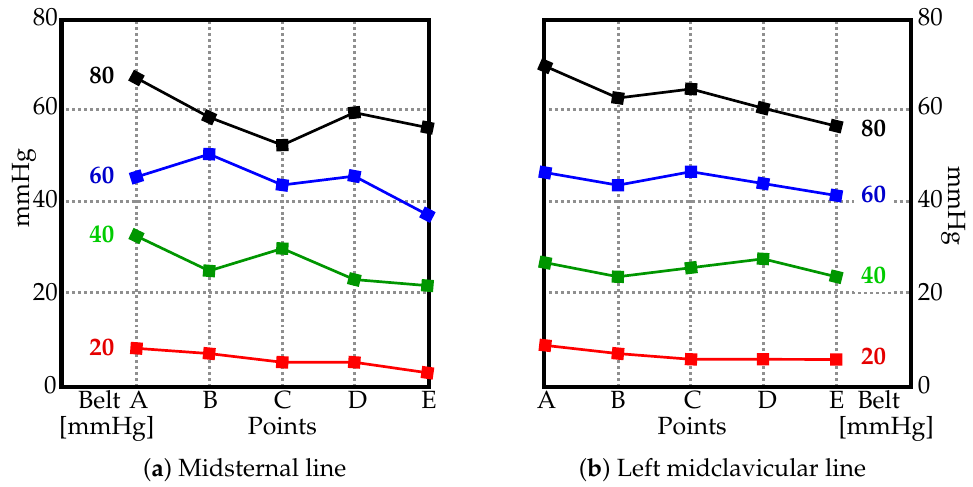
Figure 3. The pressure values [mmHG] along the ( a ) midsternal and ( b ) left midclavicular lines at different points (see Figure 1) with the belt inflated from 20 to 80 mmHG.